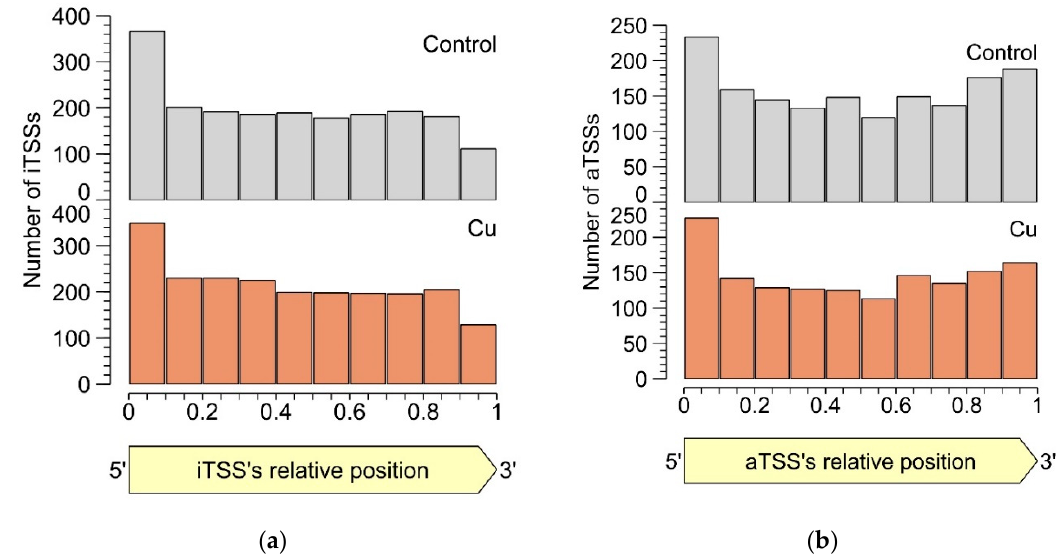
Figure 4. Percentile-wise distribution of iTSSs ( a ) and aTSSs ( b ) positions relative to the cognate CDS.